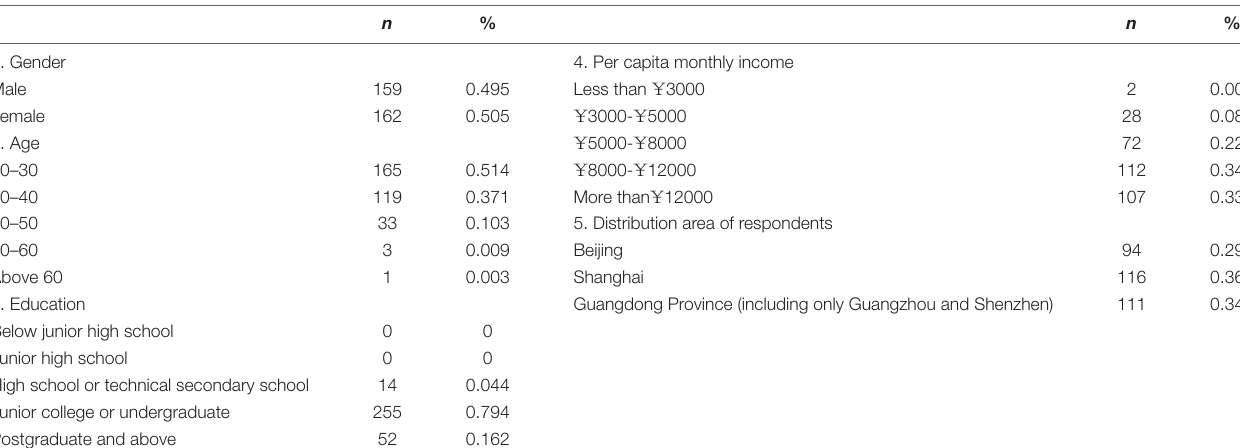
TABLE 1 | Demographic profile of the sample ( N =